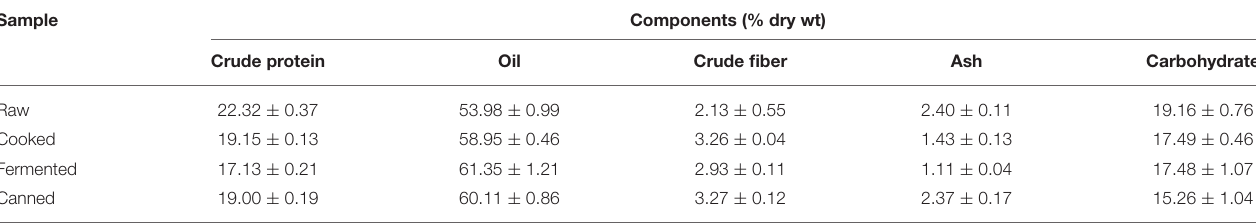
TABLE 2 | Effect of processing on the proximate chemical composition of African oil bean seeds (mean ± s.d.).